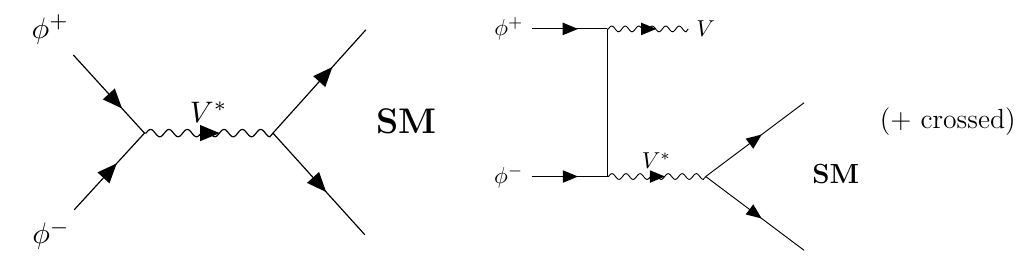
Figure 1 . The two basic processes of interest to us in this paper symbolically employing the case of complex scalar DM as a representative example. (Left) DM annihilation into SM final states via s -channel DP exchange. (Right) The same process with an additional DP emitted from the initial state producing u − and t − channel graphs. For the case of complex scalars the 4-point vertex graph (not shown) is also